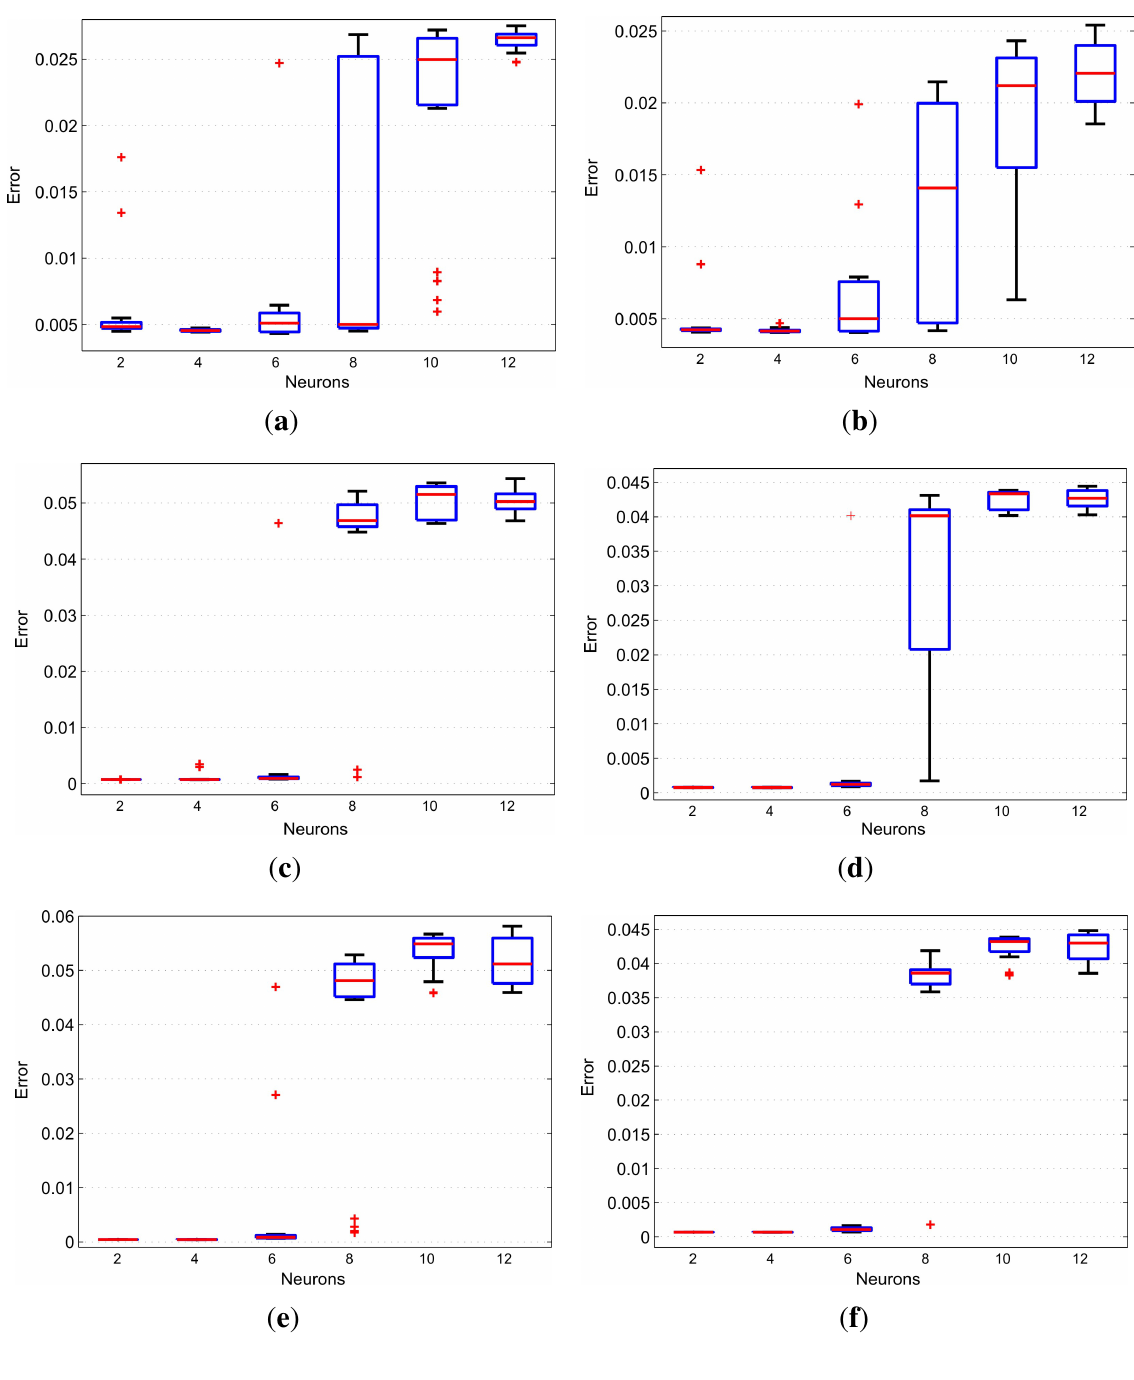
Figure 10. Number of hidden layer neurons: ( a ) humidity at point A; ( b ) temperature at point A; ( c ) temperature at point B; ( d ) temperature at point C; ( e ) temperature at point D; ( f ) temperature at point